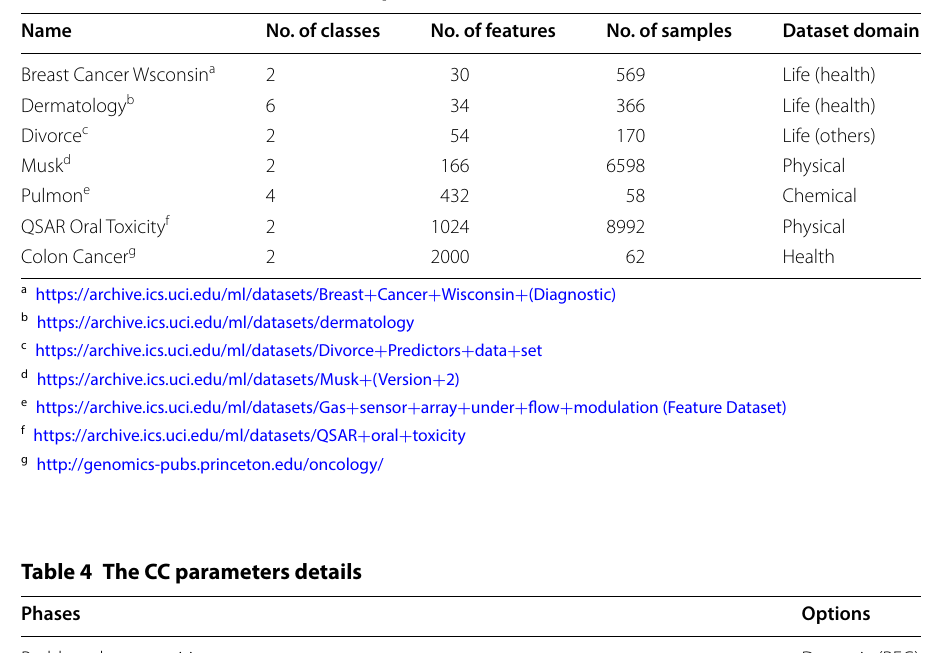
Table 3 The datasets used for the experiments